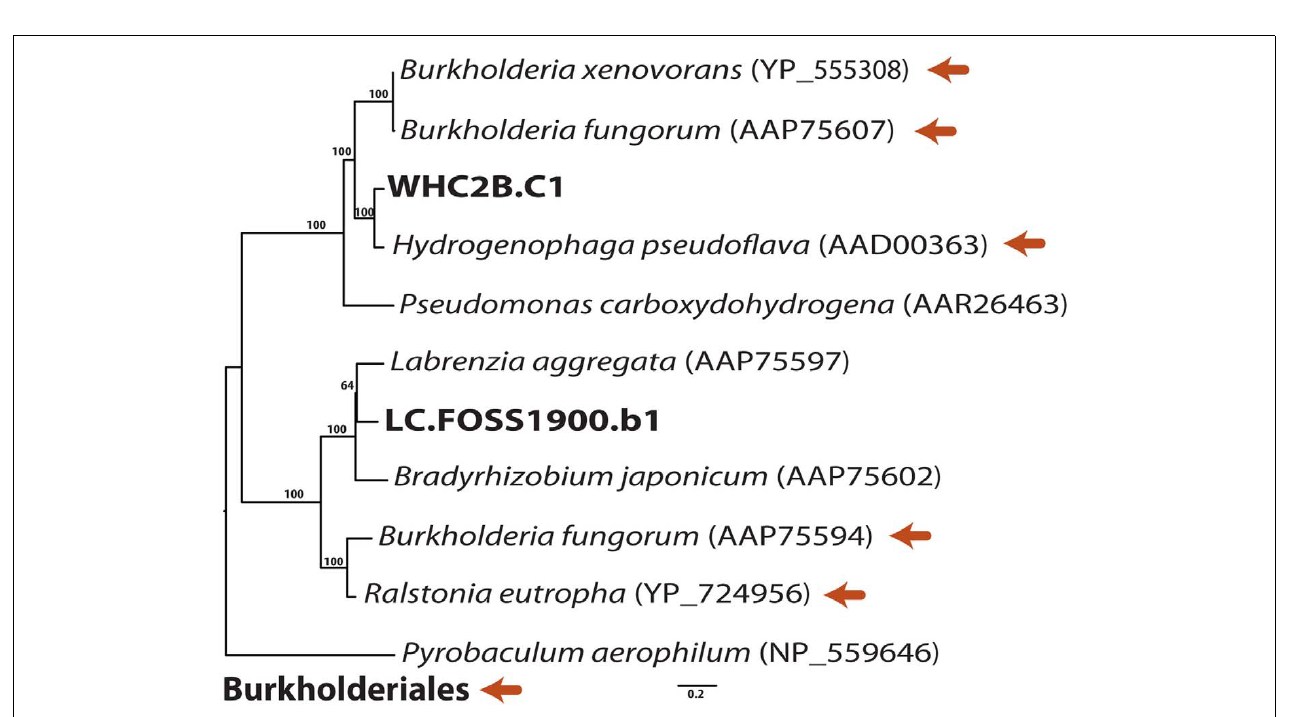
FIGUREA1 | Phylogenetic relationships of putative carbon monoxide dehydrogenase (CODH) sequences in the longestWHC2b contig and in a Lost City shotgun sequencing read. Burkholderiales reference sequences are indicated with orange arrows. Maximum-likelihood bootstrap support values > 50 are shown.